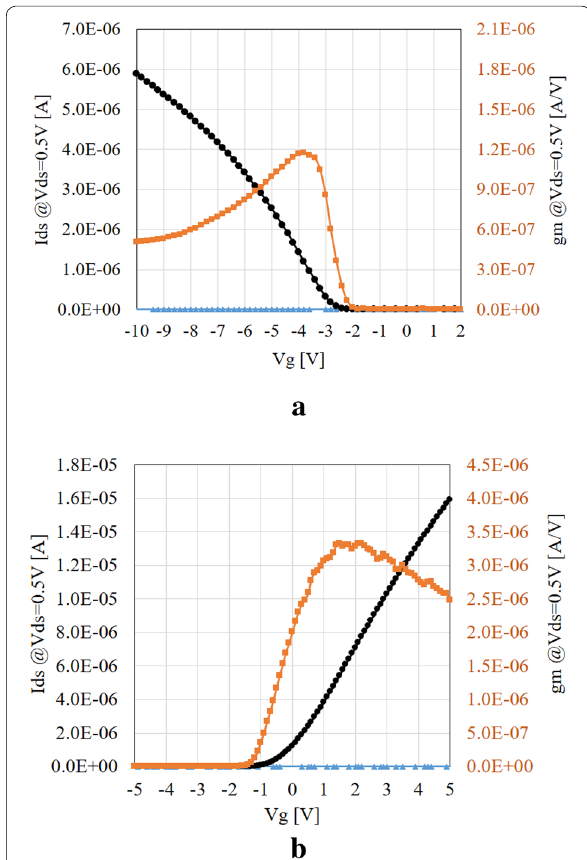
Fig. 2 I ds ‑V g characteristics of nanoFET device with the extended gate electrode a p‑type nanoFET device, b n‑type nanoFET